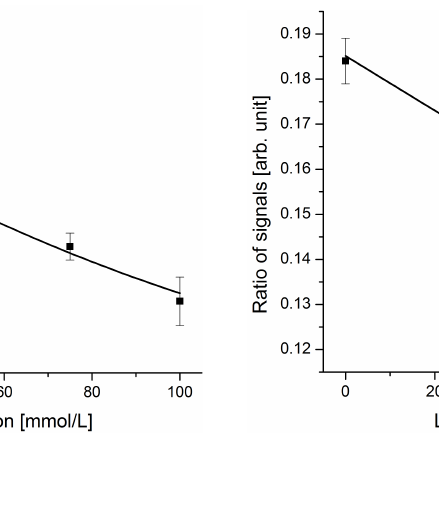
Figure 8. Sensor output of two different devices for complex analytes. Known concentrations of lactose were added to untreated lactose-free milk. The high optical absorbance of milk explains the increased standard deviations. ( a ) The device with an incident angle of 70.0 ◦ is operating outside the linear region. ( b ) The device with an incident angle of 72.5 ◦ allows operation in the linear range. A univocal discrimination of samples in a step size of below 25 mmol/L is